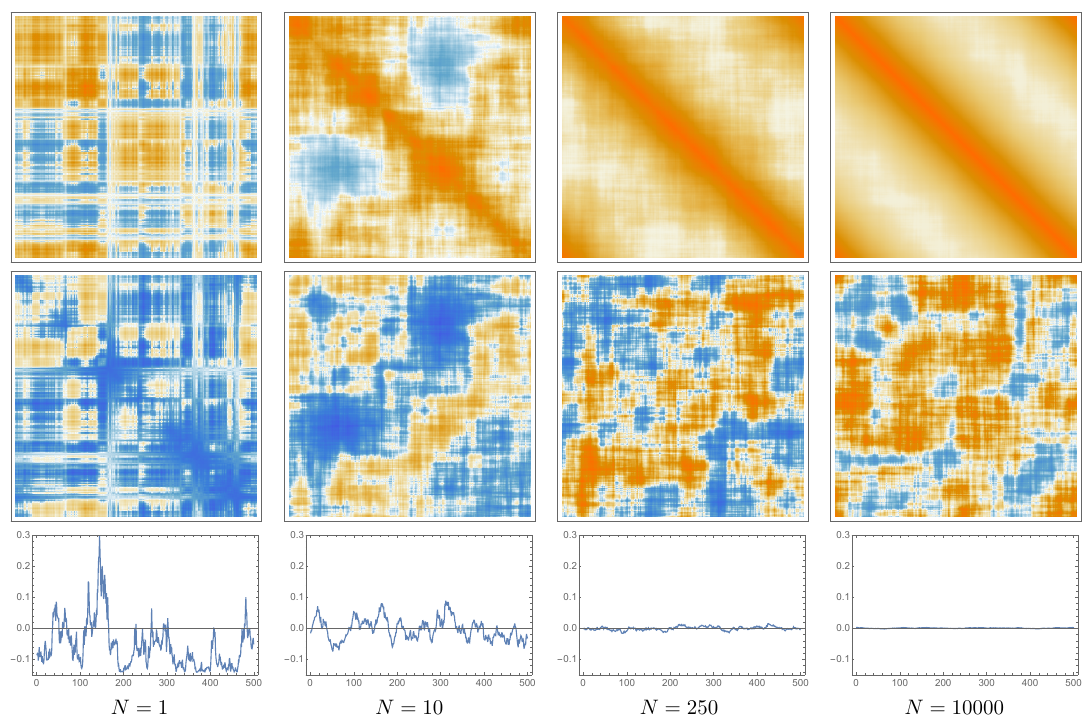
Figure 3 . Samples of, from top to bottom, H xy , B xy = H xy (cid:0) h H xy i , ~ (cid:12) ( x ) = B xx on 1d circle of size L and lattice spacing L , K = 500, with D = discrete Laplacian plus small mass term (cid:24) 1 K From left to right, N = 1 ; 10 ; 250 ; 10000. H for N = 1 ; 10 has reduced rank 2 N